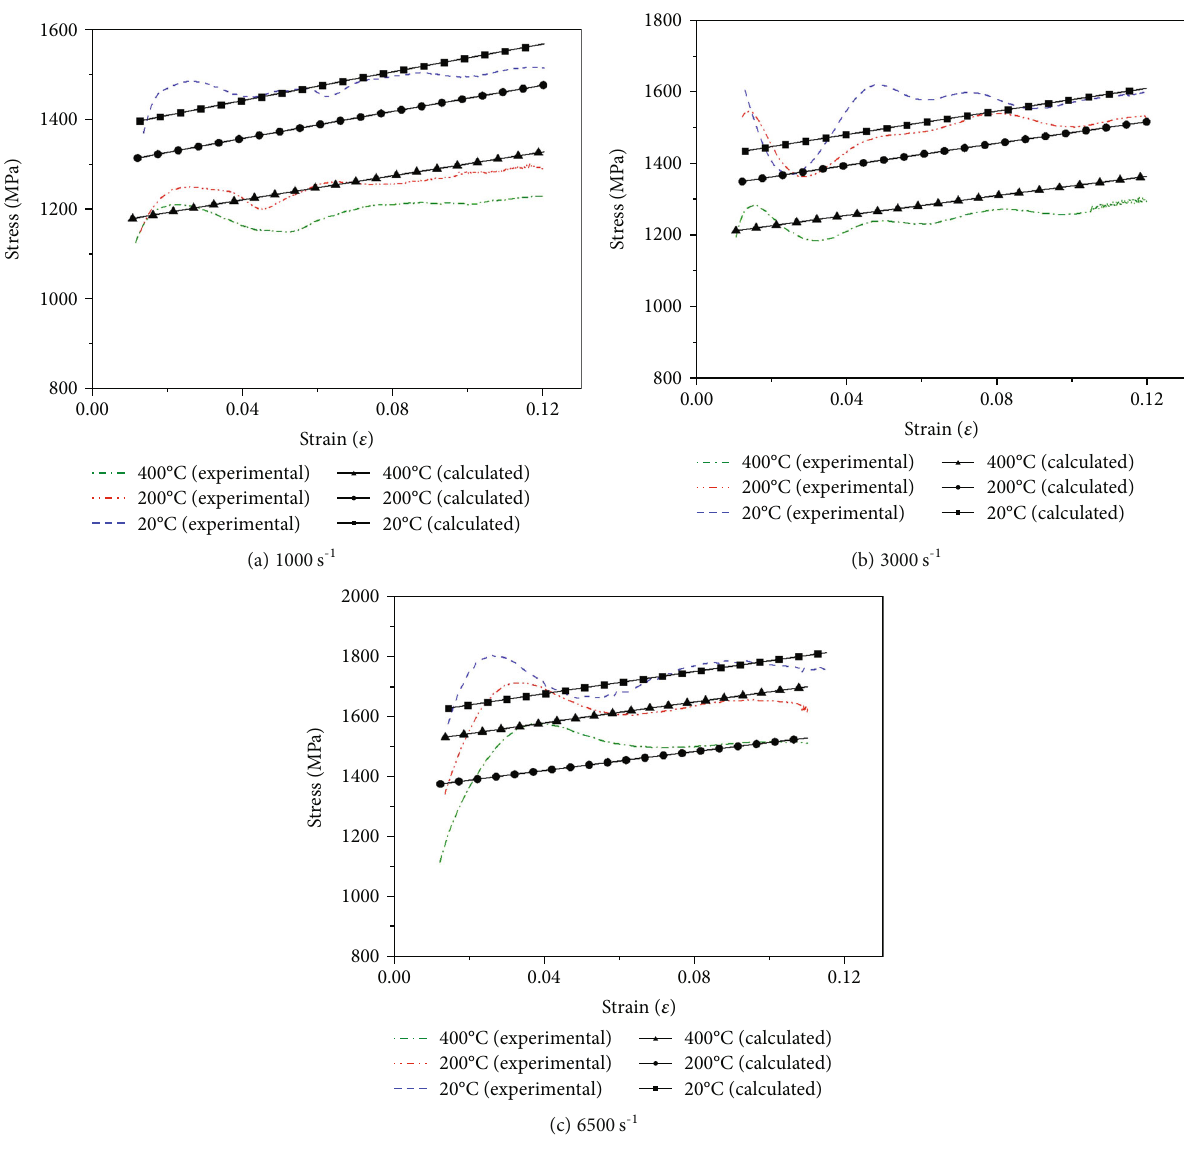
Figure 13: Comparison of calculation curves and test results.